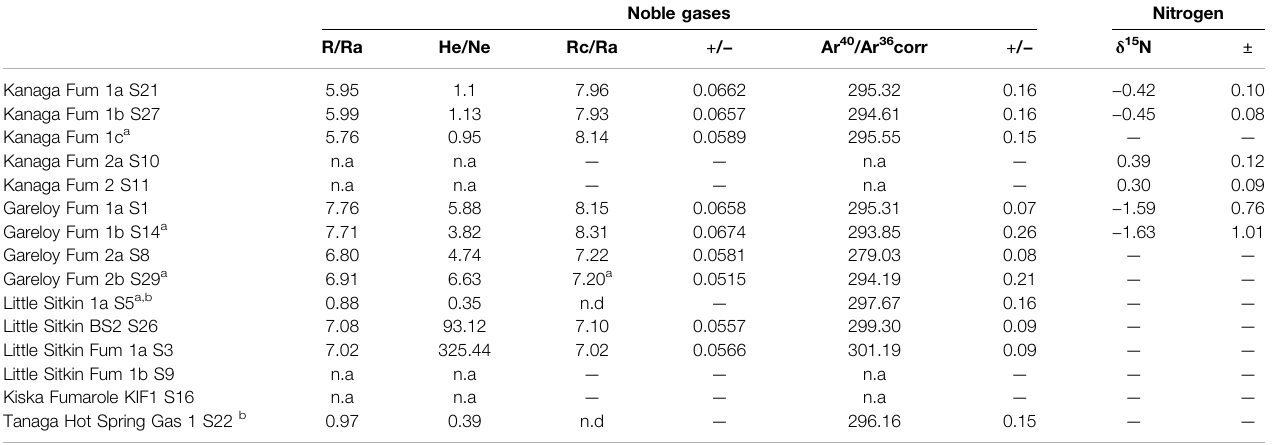
TABLE 2 | Noble gas and nitrogen stable isotopes.